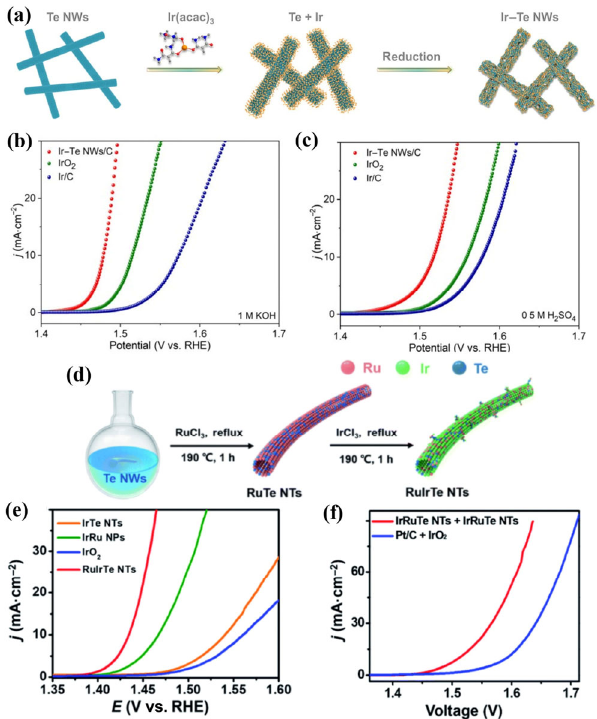
Figure 2 (a) The process of preparing Ir-Te NWs using Te nanowires as templates. (b) The LSV curves of the Ir-Te NWs/C, IrO 2 and Ir/C in 1 M KOH. (c) The LSV curves of the Ir-Te NWs/C, IrO 2 and Ir/C in 0.5 M